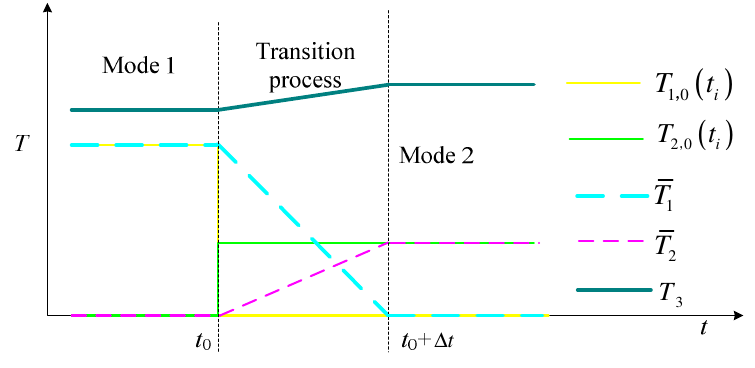
Figure 6. Schematic of mode shifting based on BDCS.